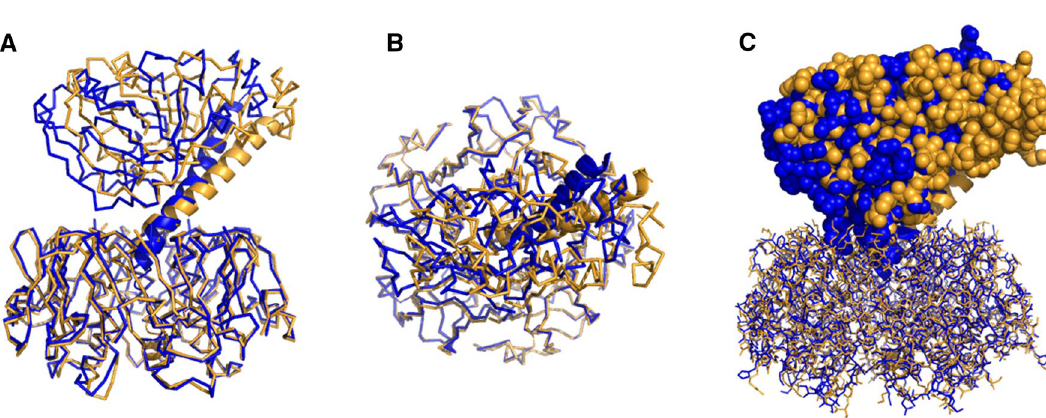
Figure 7. Superimposed structures of CT (blue) and LT (gold) (PDB entries 1s5f and 1lts, respectively). B pentamers of the two structures have been superimposed using the Align function of PyMOL to underscore the different A2 subunit orientations and distinct geometric positioning of the A1 subunits ( A,C : side view, B : top- down view). Protein main chains in ( A ) and ( B ) are shown in ribbon format except for A2 domains, which are in cartoon format. In ( C ), the B pentamer is shown in “lines” format and the A1 and A2 chains in spheres and cartoon formats, respectively. Images are generated by PyMOL 1.8.6.0 (Schrödinger,